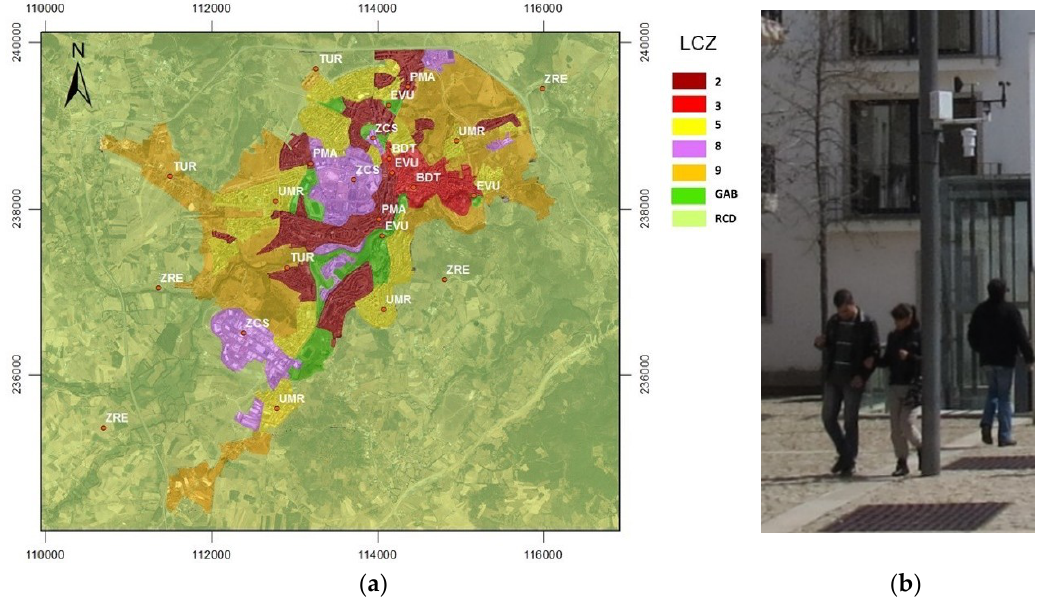
Figure 2. ( a ) Measuring network and its distribution in relation to the Local Climate Zones (LCZ)